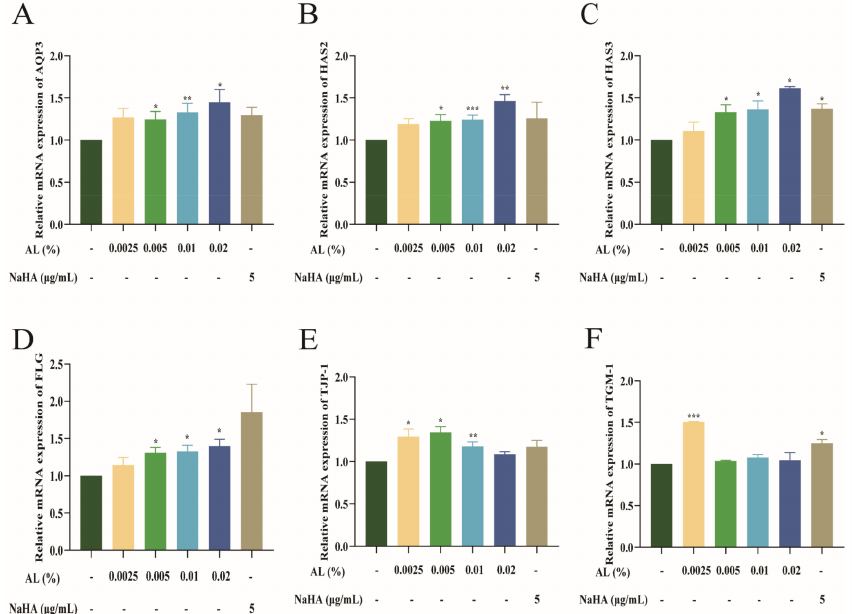
Figure 2. Effect of AL on the mRNA expression of moisturizing-related genes in HaCaT cells. Relative expressions of AQP3 (A ), HAS2 ( B ), HAS3 ( C ), FLG ( D ), TJP − 1 ( E ), and TGM − 1 ( F ) were detected in HaCaT cells via RT-qPCR. Results are expressed as means ± SDs of three independent experi- ments. Relative expression quantity values were calculated relative to the β -actin gene. *** p < 0.001, ** p < 0.01, * p < 0.05 compared to the normal group (no treatment). One-way ANOVA was used to evaluate